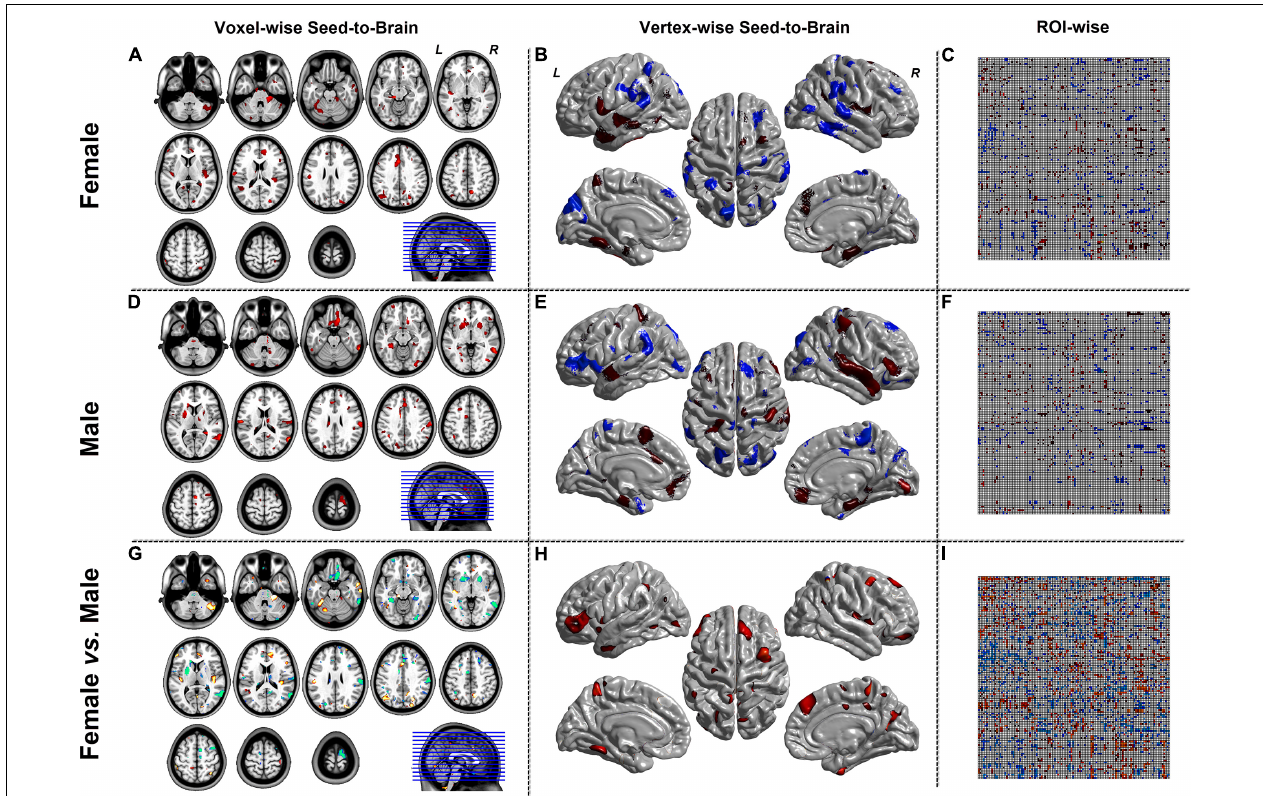
FIGURE 5 | The results of CaSCN mode with Y (Brain/Target ROI)-to-X (seed). Panels (A , D , G) were the results of seed-to-brain connectivity of the GMV. Panels (B , E , H) were the results of seed-to-brain connectivity of thickness. Panels (C , F , I) were the results of ROI-wise connectivity of the GMV with the AAL template. All results were set at the threshold of p < 0.05